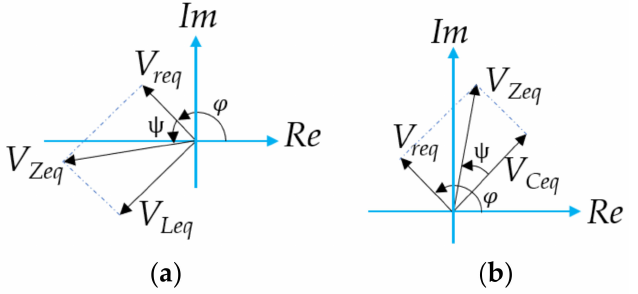
Figure 7. Vector representation of the relationship between ϕ and ψ angles. ( a ) Resistive–inductive equivalent impedance. ( b ) Resistive–capacitive equivalent